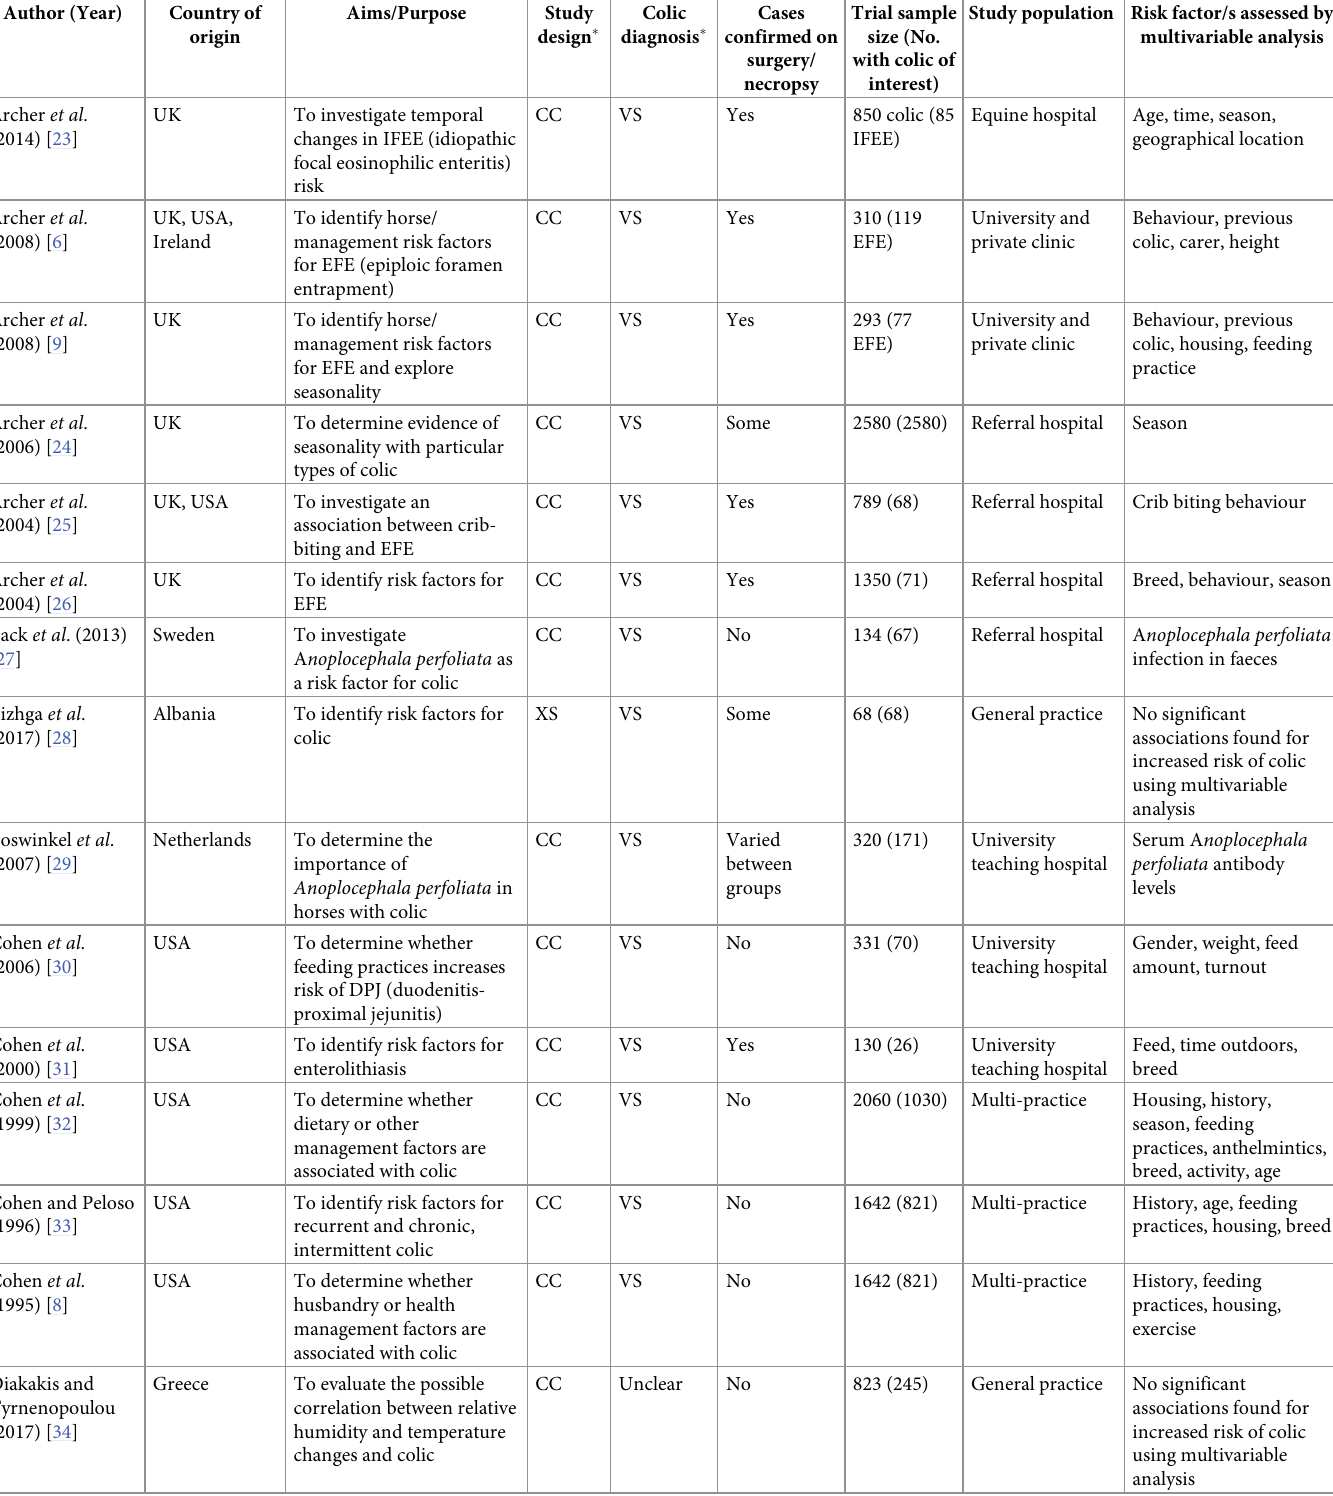
Table 3. Study characteristics for 52 publications identified in a scoping review for risk factors for colic in the horse. Author